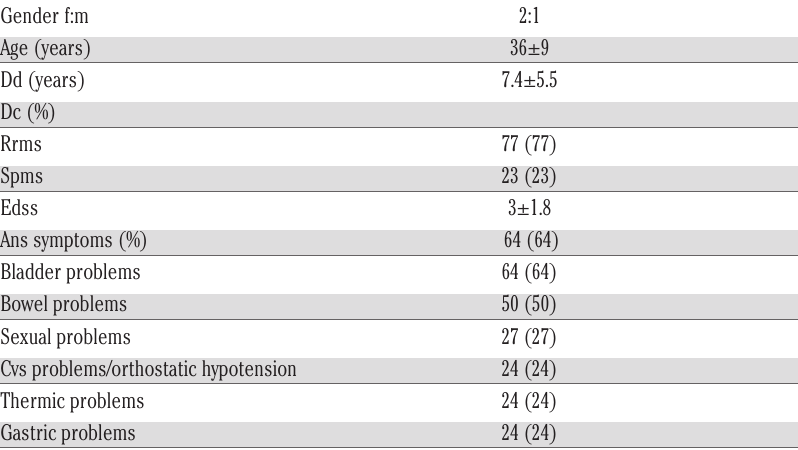
Table 1. Demographic and clinical characteristics of patients.